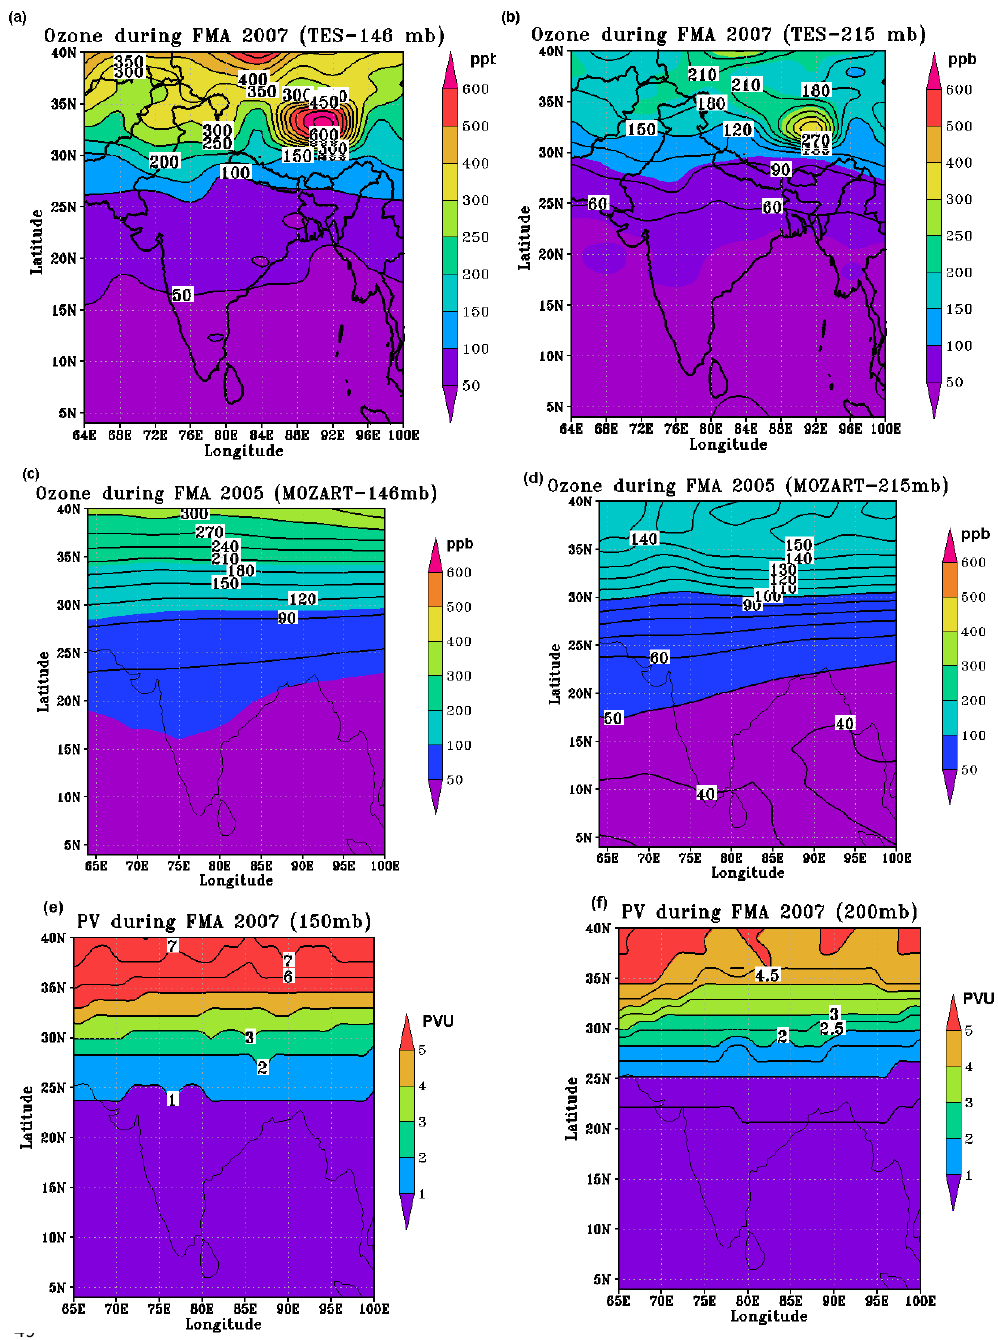
Fig. 6. Latitude-longitude distribution of seasonal averaged ozone (averaged for February-March-April months) over the Indian region (a) at 146mb as obtained from TES measurements for the year 2007; (b) at 215mb as obtained from TES measurements for the year 2007; (c) at 146mb as obtained from MOZART model simulation for the year 2005; (d) at 215mb as obtained from MOZART model simulation for the year 2005; (e) latitude-longitude cross-section of seasonal averaged (February-March-April) potential vorticity at 150mb; (f) latitude- longitude cross-section of seasonal averaged (February-March-April) potential vorticity at